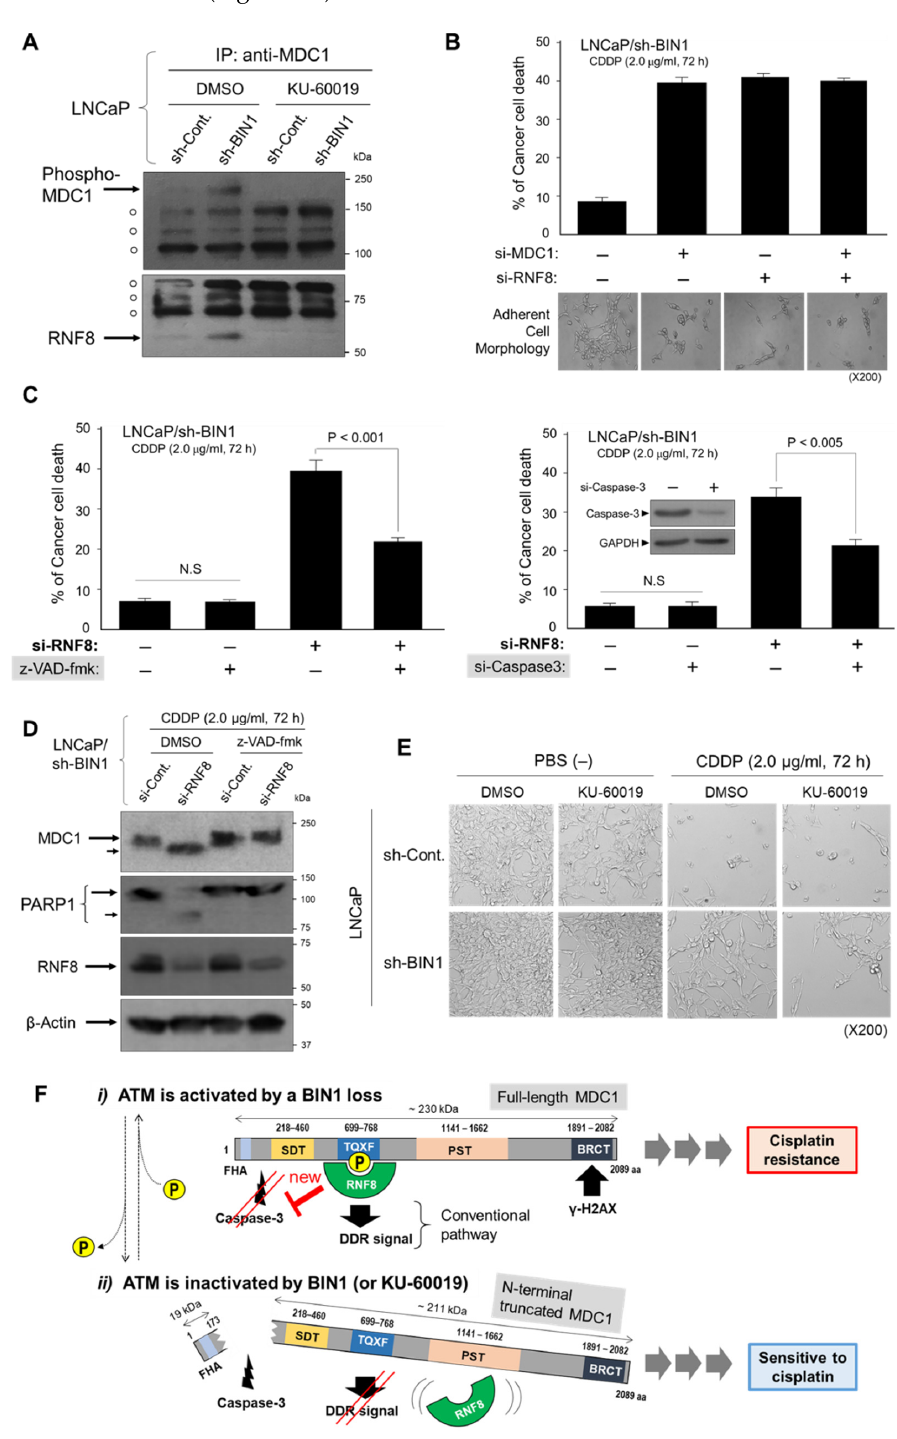
Figure 4. ATM-phosphorylated MDC1-RNF8 complex prevents MDC1 protein from proteolytic cleavage by caspase-3 and sustains cisplatin resistance caused by a BIN1 loss. ( A ) The cleared pro-